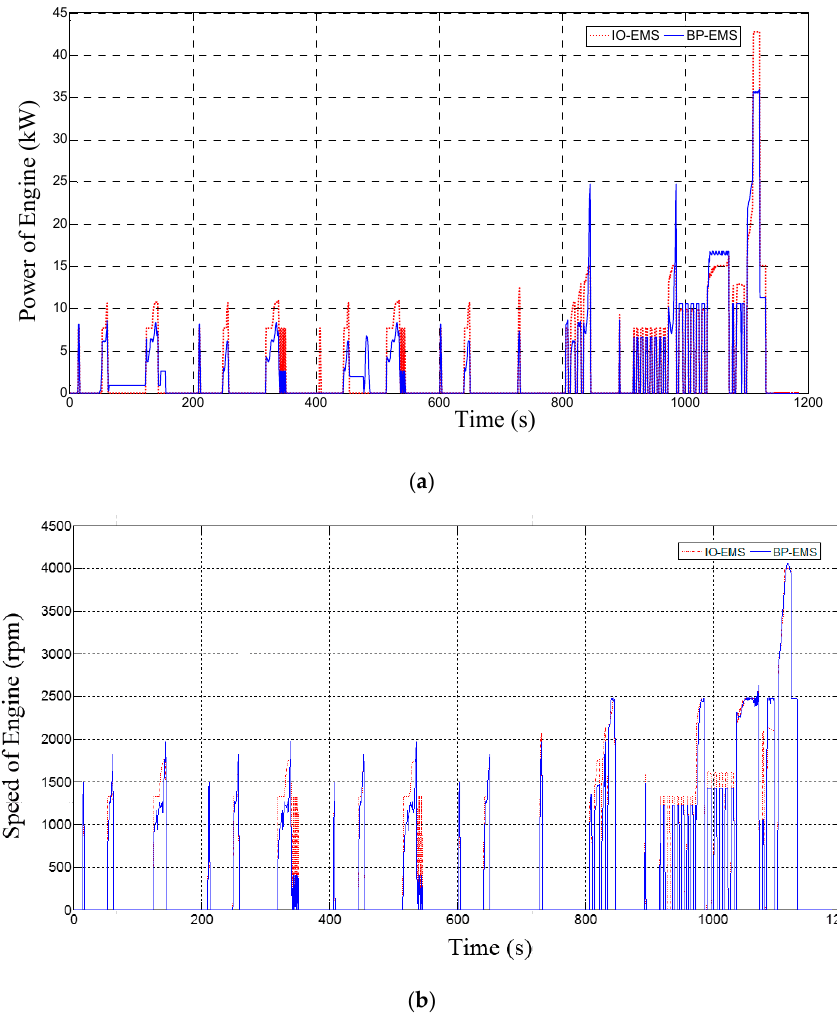
Figure 13. Power ( a ) and speed ( b ) of ICE during NEDC driving cycle.